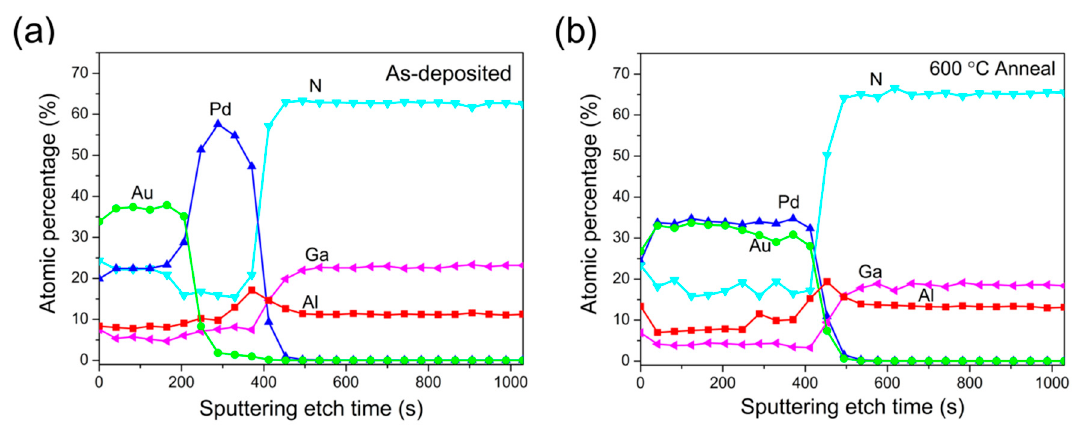
Figure 3. Depth-profiling of the PdAl/Au metal stack on p-AlGaN using X-ray photoelectron spectroscopy (XPS): ( a ) as-deposited and ( b ) annealed at 600 ° C.